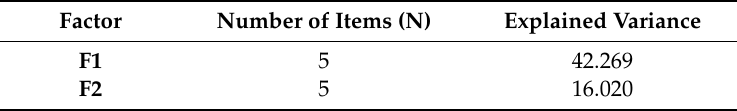
Table 3. Number of items and explained variance.